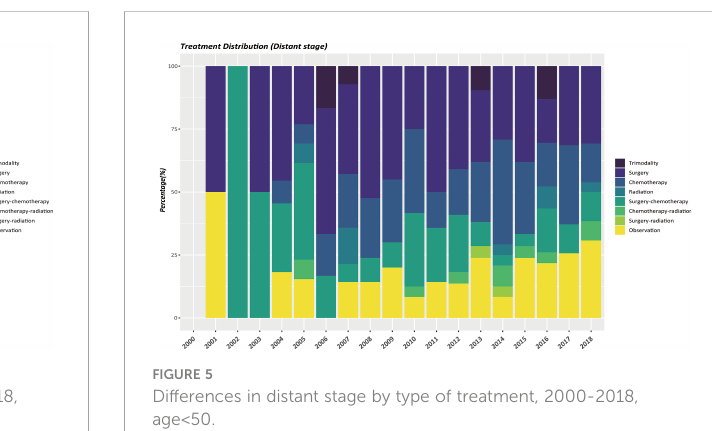
FIGURE 4 Differences in regional stage by type of treatment, 2000-2018, age<50.